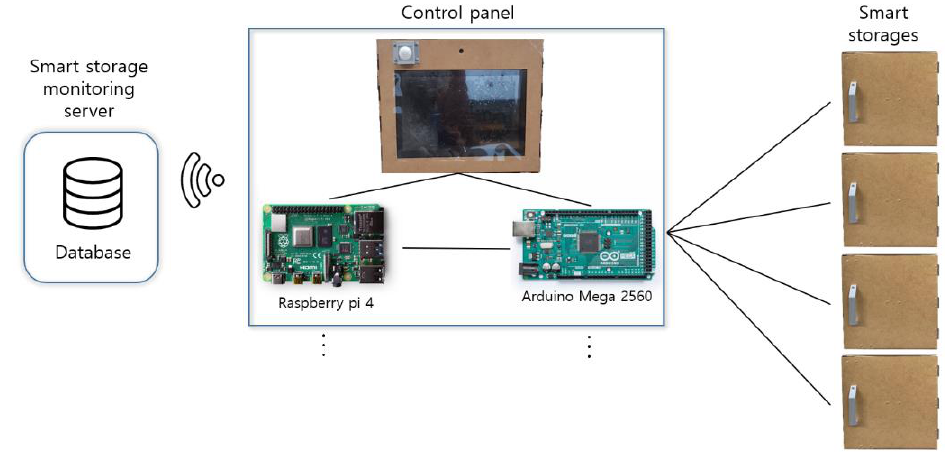
Figure 2. An overview of the prototype smart storage system.